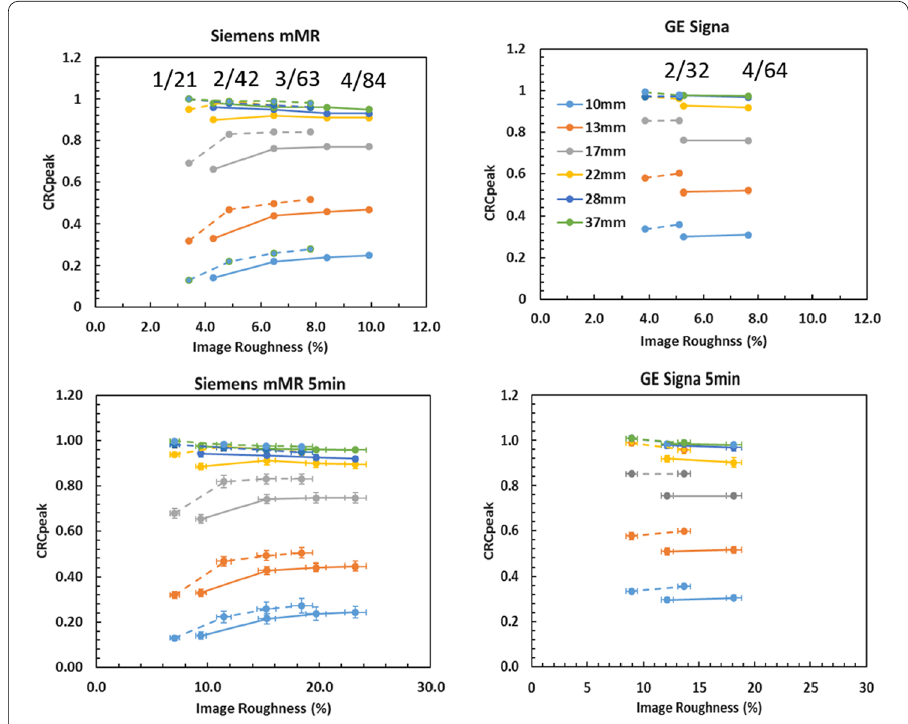
Fig. 3 Image roughness versus CRC peak plots for the NEMA standard set of spheres for the Siemens mMR (left) and GE Signa (right). The top row shows plots for the whole 30 min of listmode data and the bottom row, the average value over six frames of 5 min duration. Error bars in the bottom plot show the ensemble noise over the six realizations. The dotted lines represent the reconstructions with the use of resolution recovery (either PSF or IR, depending of vendor). The numbers of iterations and updates are indicated on the top